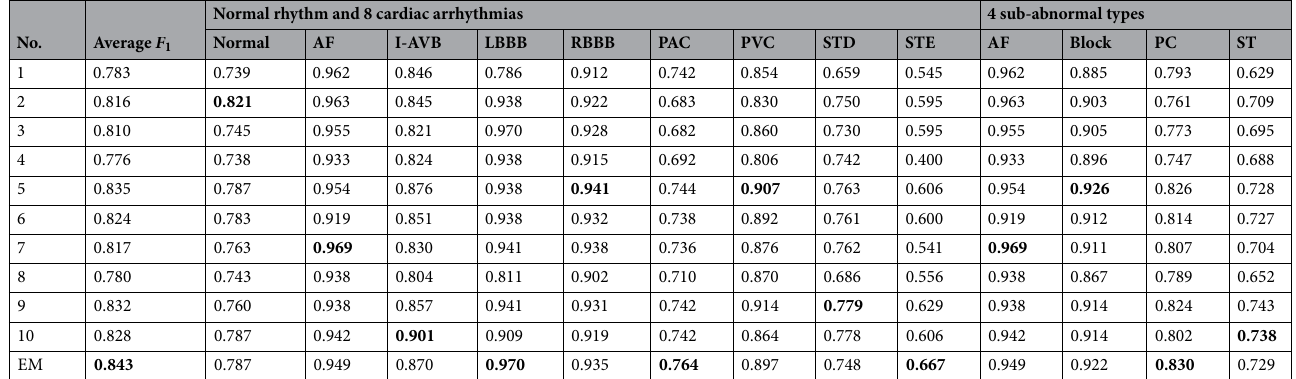
Table 3. Comparison of F 1 scores between the ensemble model and the single optimal models on the small number of test set. Significant values are in